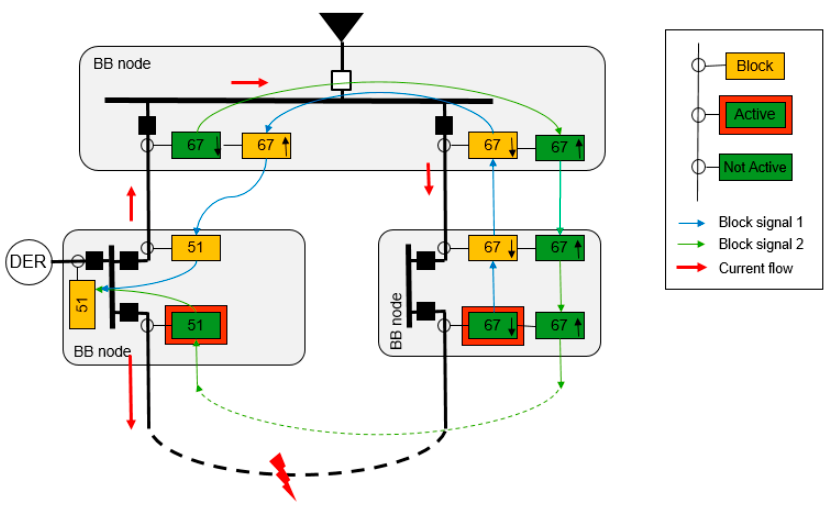
Figure 6. Electrical ring main system with DER in islanded mode.